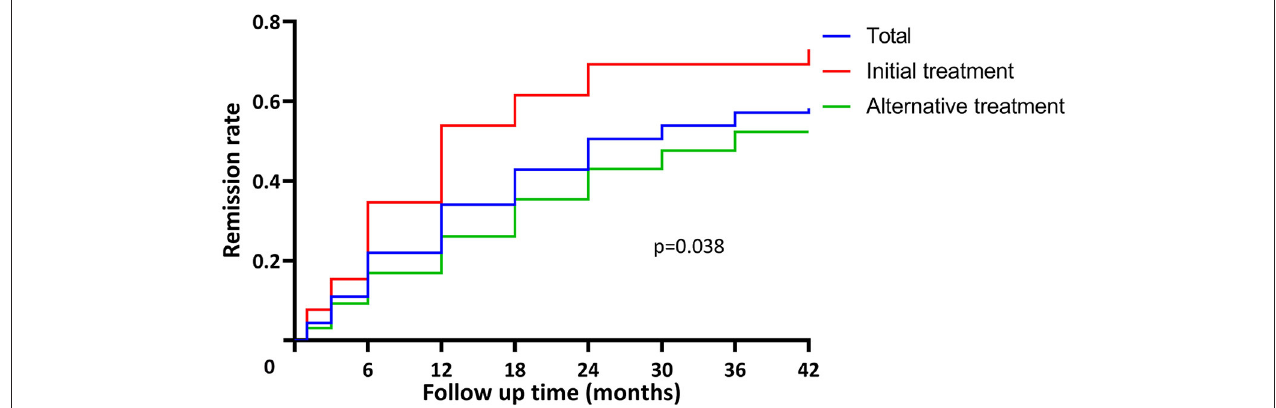
FIGURE 2 | Time to remission in patients with pMN receiving rituximab treatment. The remission rate was 58.2% (53/91) in total. The initial therapy group had higher remission rate compared to the alternative therapy group [19/26 (73.1%) vs. 34/65 (52.3%), P = 0.038] and achieved remission sooner [12.0 (6.0, 18.0) vs. 15.0 (6.0, 24.0) months].